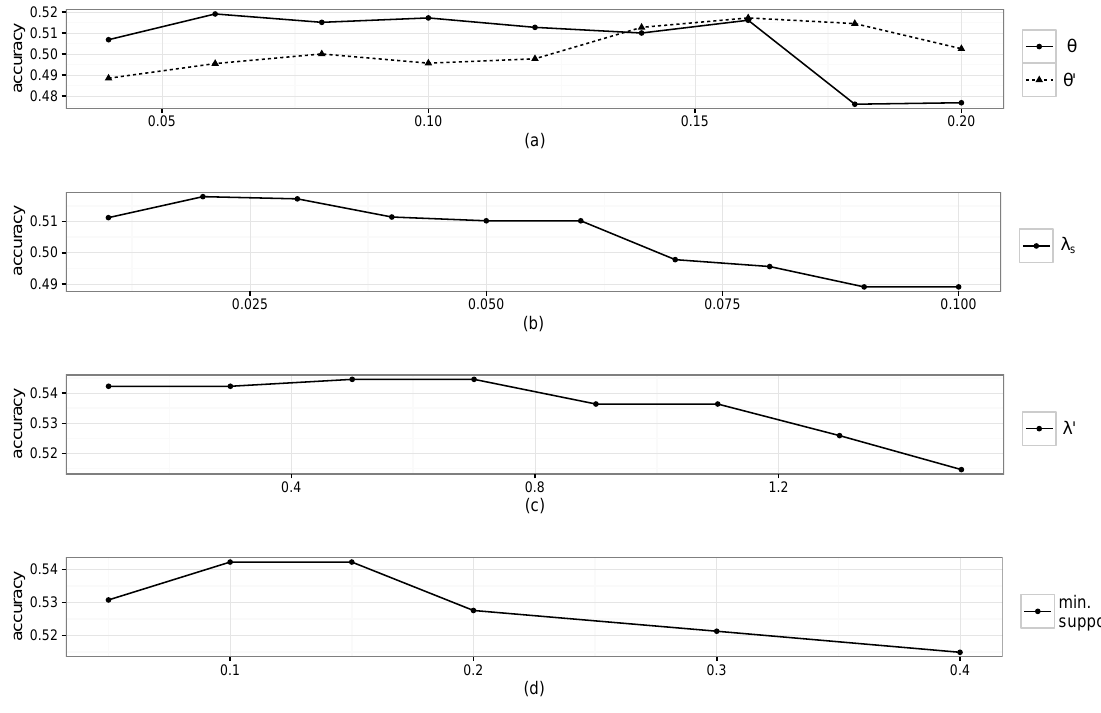
Figure 5. Accuracy results when varying parameters: ( a ) θ and θ (cid:48) ; ( b ) λ s ; ( c ) λ (cid:48) ; and ( d ) minimum support. The maximum gap, maximum window size, minimum support, λ and λ (cid:48) are the parameters involved in the gapped sequence mining. Individual effects of λ (cid:48) and the minimum support on the accuracy are respectively plotted in Figure 5c,d, where the maximum performance was achieved when setting λ (cid:48) and the minimum support to 0.5 and 0.15, respectively. Performance differences